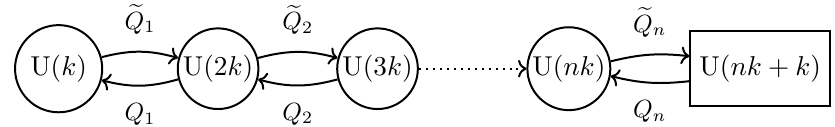
Figure 14 . Linear tail of length n + 1. The rectangle denotes a global symmetry which is gauged in the E-type quiver (central node).